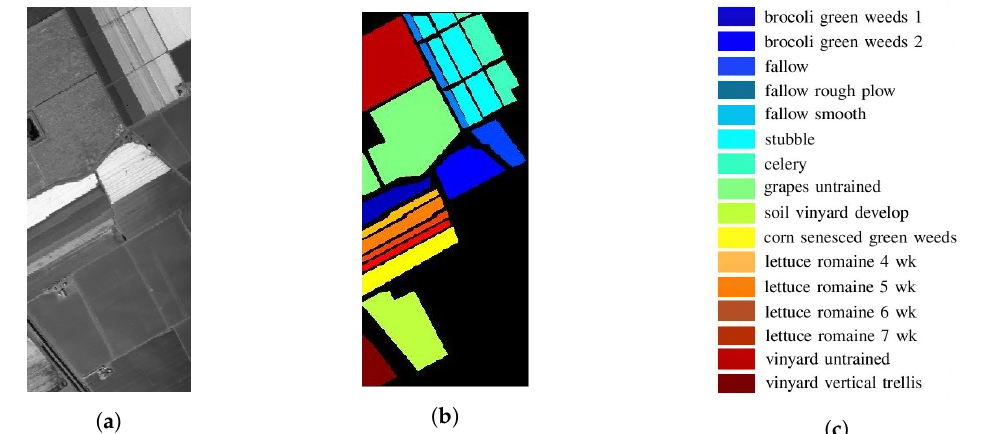
Figure 14. Images of Salinas Valley, centered at 36 ◦ 40 (cid:48) 39.8568 (cid:48)(cid:48) N, 121 ◦ 39 (cid:48) 19.8072 (cid:48)(cid:48) W [47], area size is